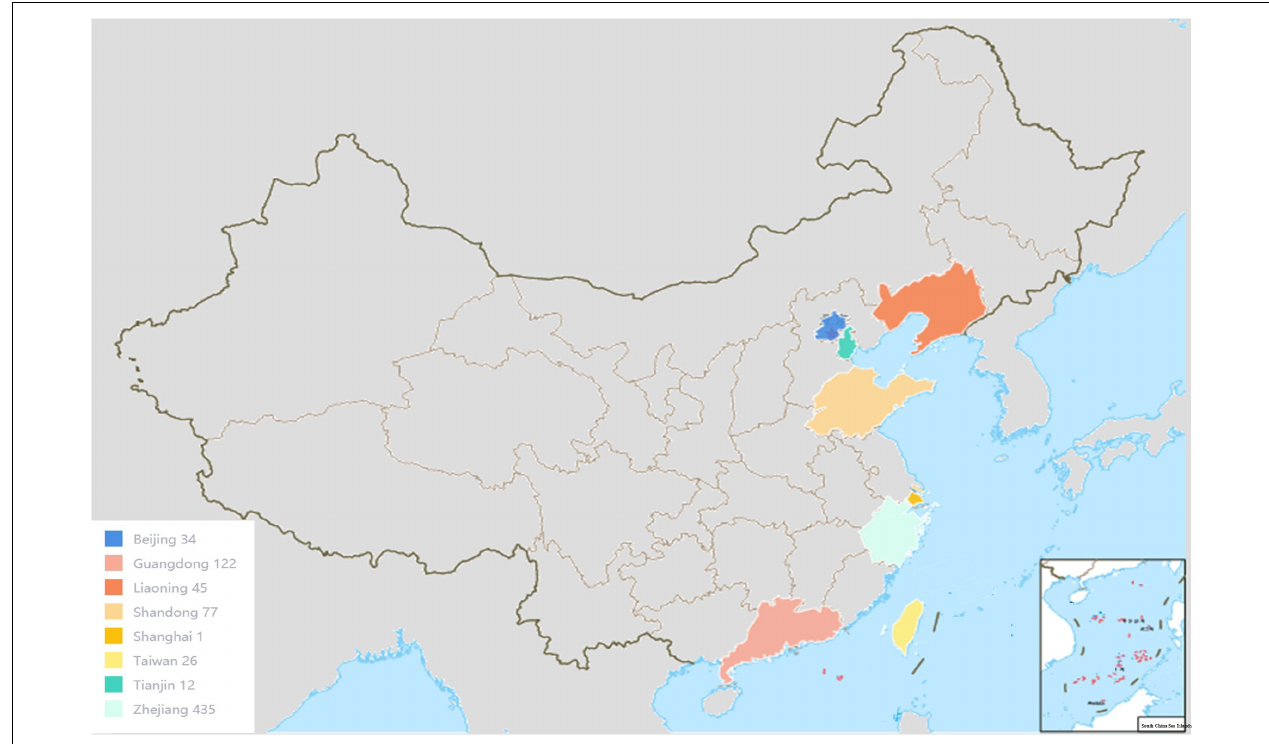
FIGURE 1 | The main geographical distribution of Vibrio strains.